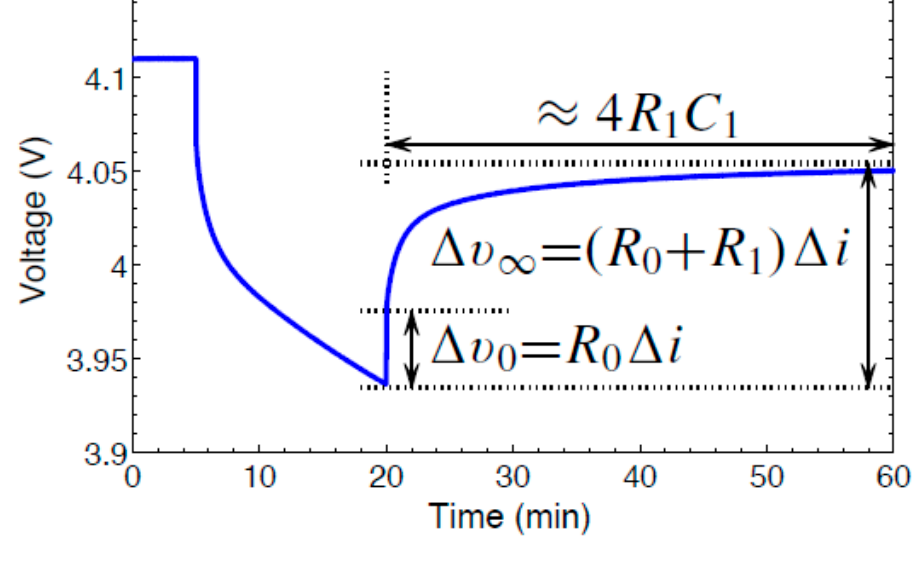
Figure 4. Polarization of Voltage.